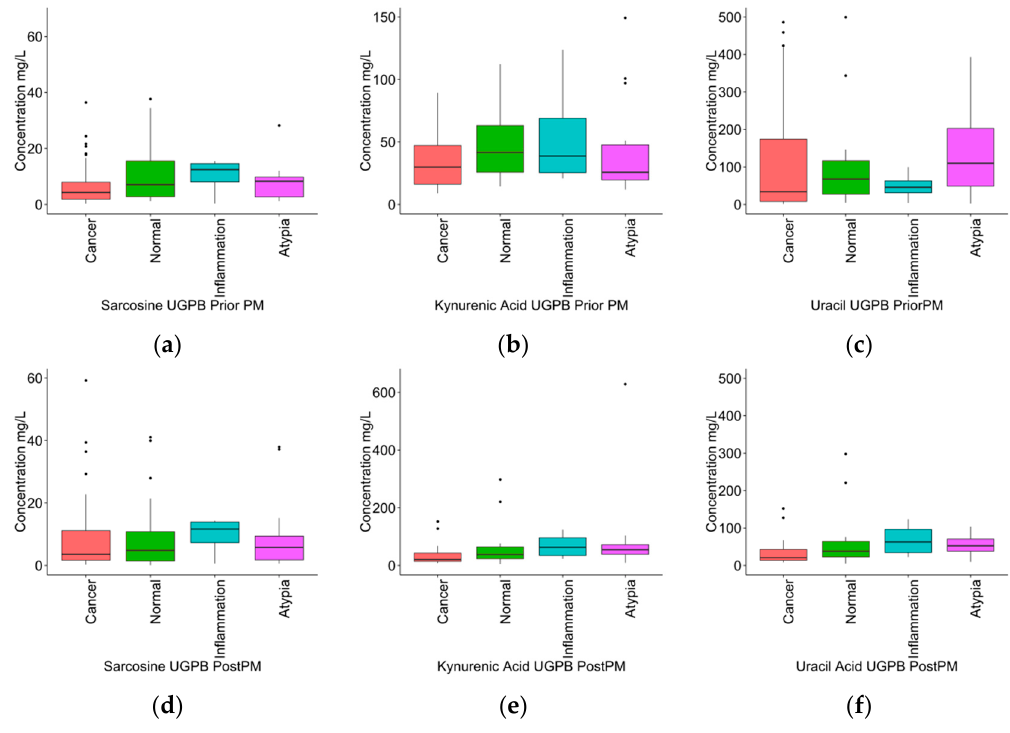
Figure 1. Box plots of potential markers ( a ) sarcosine, ( b ) kynurenic acid, and ( c ) uracil, in urine samples of patients in group B (UGBP) before prostatic massage and ( d ) sarcosine, ( e ) kynurenic acid, and ( f ) uracil. Boxes are drawn from the 25th to 75th percentiles in the concentration distribution.